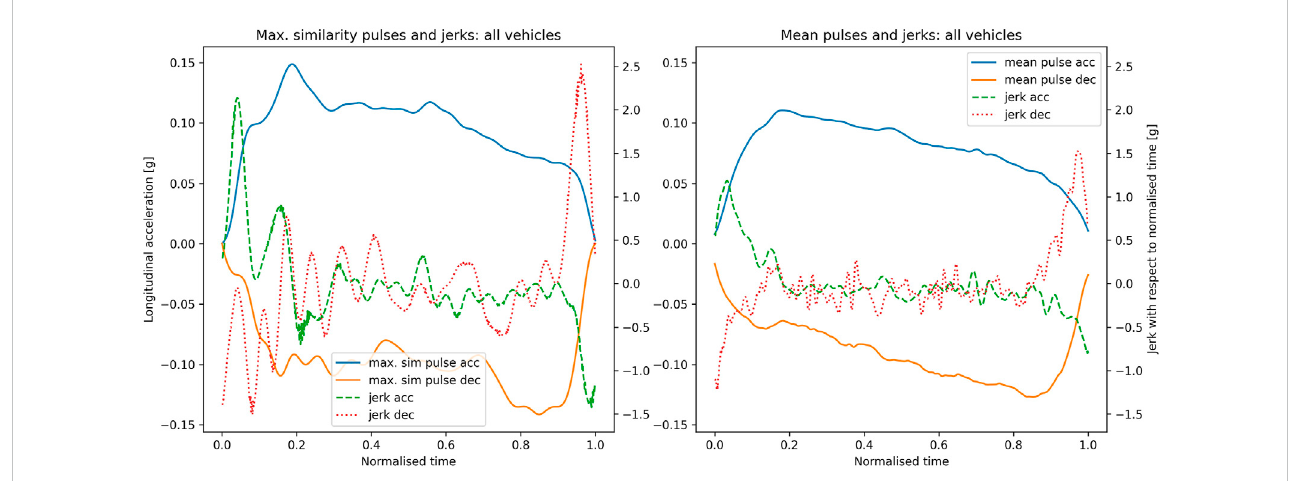
FIGURE 4 Jerk estimates for maximum similarity pulses (left) and unconstrained mean pulses (right), with coef fi cients up to N = 200 for all vehicle